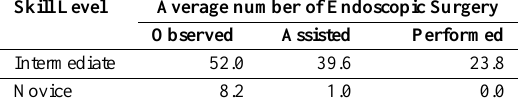
Figure 2. Eye-Gaze and Hand Motion Coordinates in